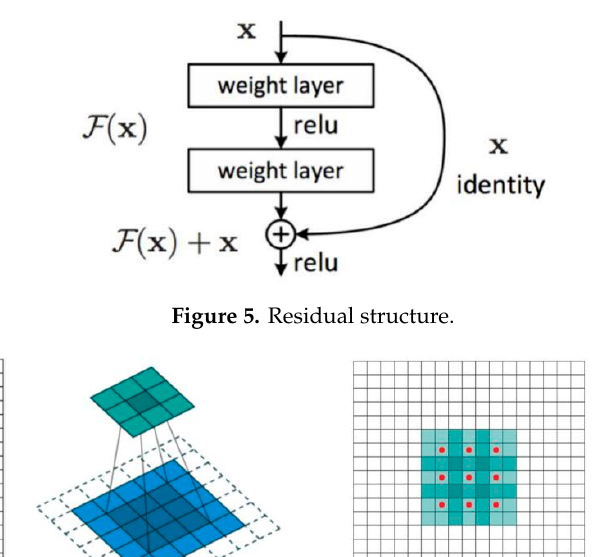
Figure 5. Residual structure.